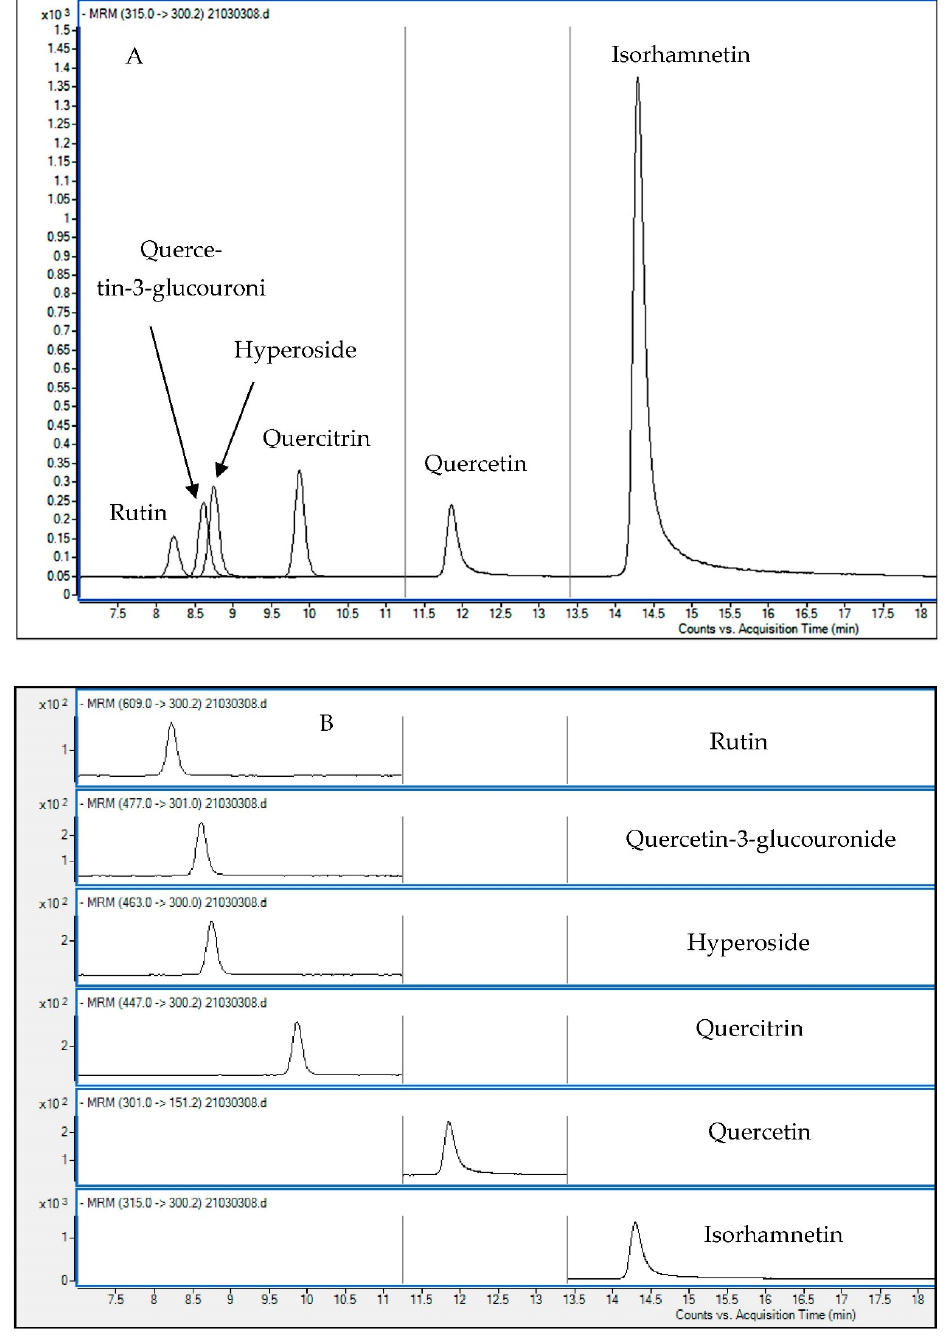
Figure 1. HPLC-MS/MS chromatograms of a standard mixture of the 6 analyzed quercetin deriva- tives (0.5 mg L − 1 ) plotted as overlapped ( A ) and separate ( B ) multiple reaction monitoring (MRM) transition of each analyte.